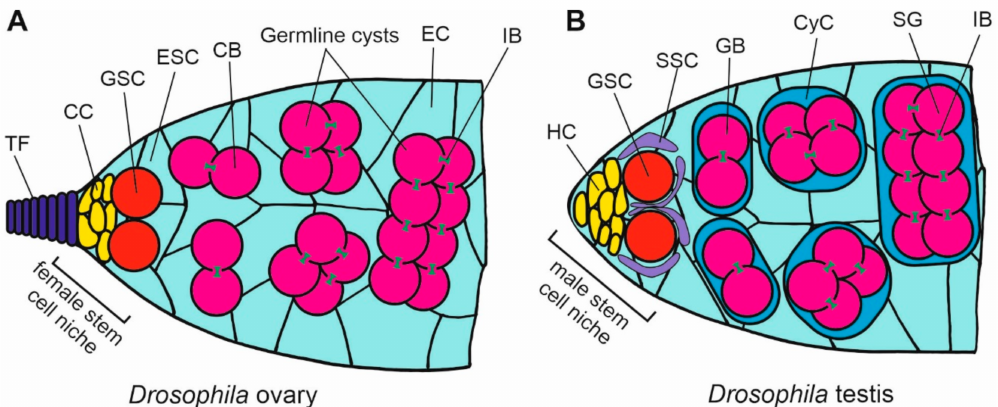
Figure 4. Scheme of organization of the stem cell niche in Drosophila ovary and testis. ( A ) In the ovary germarium, the female stem cell niche at the apical tip of the ovariole is maintained by the signaling from the somatic cap cells (CC), which are located below the terminal filament (TF), and bind, through E-cadherin, the germline stem cells (GSC). The divisions of GSCs give rise to the cystoblasts (CB) that develop into germline cysts that are surrounded by the escort cells (EC) originating from the escort stem cells (ESCs). ( B ) The apical tip of testis contains the male stem cell niche in which the somatic hub cells (HC) bind germline stem cells (GSC) through E-cadherin. GSCs are enclosed by the somatic stem cells (SSCs). Dividing GSCs give rise to the cysts of gonialblasts (GB) that di ff erentiate into spermatogonia (SG) enclosed by the cyst cells (CyC). The germ cells in the cysts are interconnected by the intercellular bridges (IB) containing the ring